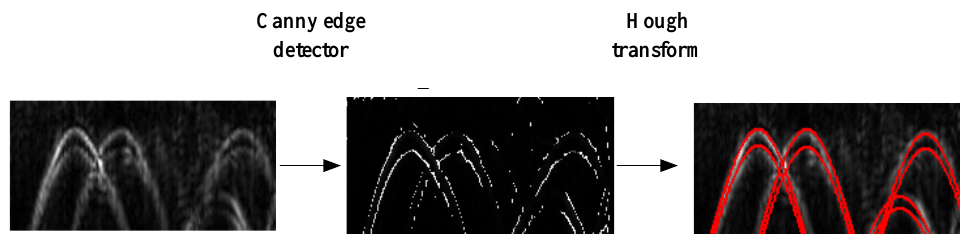
Figure 5. The result of the Hough transform. The image is in the ROI region (on the left). Then the canny edge detects result is shown. Then the Hough transform result. The hyperbola is drawn in red